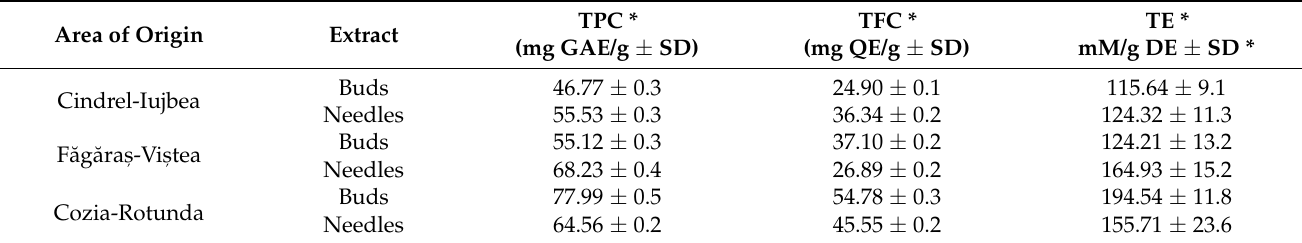
-Vi¸stea, Cozia-Rotunda in Romania. ,